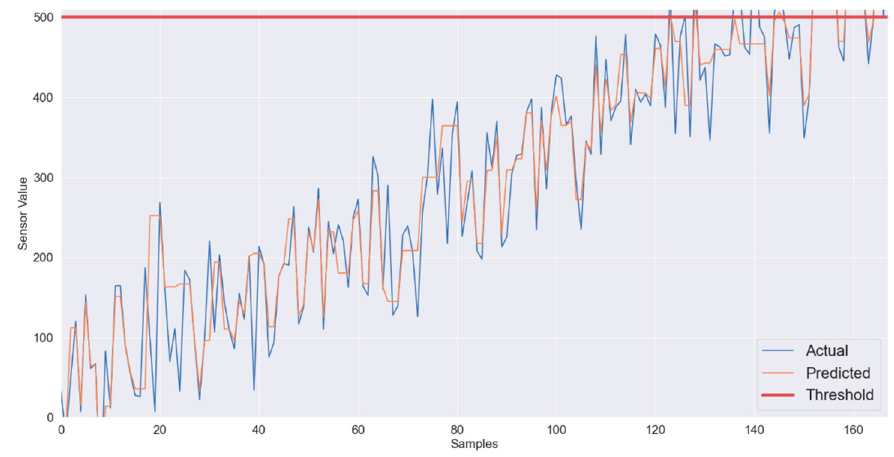
Figure 6. XGB regressor-average data variations: Predicted vs. Actual.